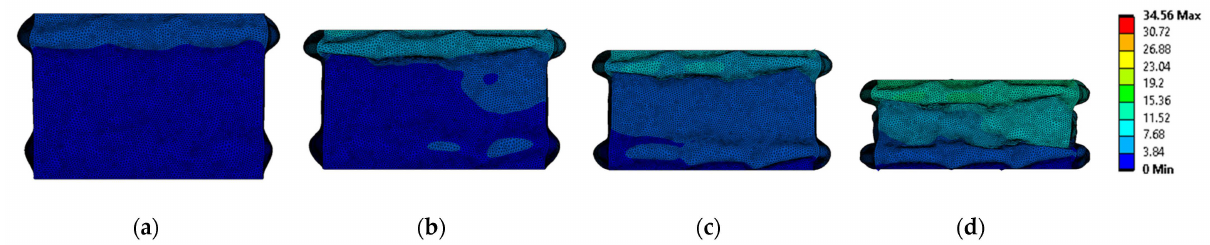
Figure 9. Deformation stages of compression of the regular scale novel honeycomb sample under axial load, reproduced using FEA: ( a ) collapse of the top end; ( b ) collapse of the bottom end; ( c ) collapse of the central part; and ( d ) densification.